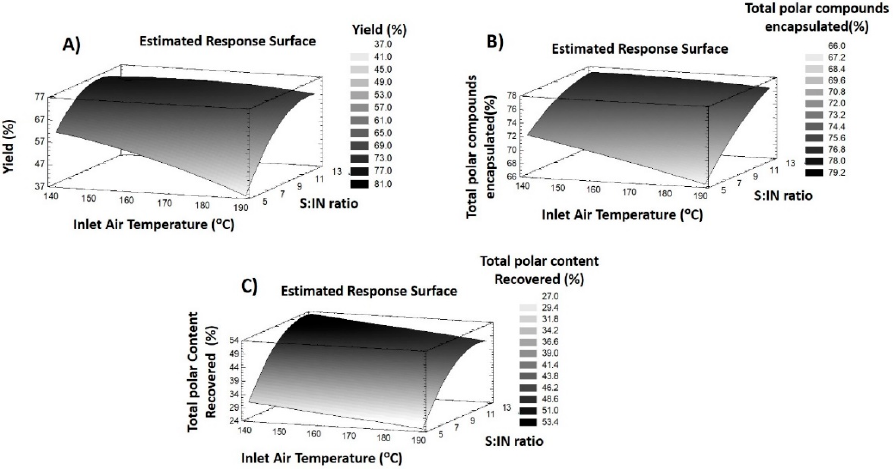
Figure 2. RSM plots of responses of inulin (IN) particles: (A ) Yield, ( B ) Total polar encapsulation and ( C ) Total polar recovery. Sample:Inulin (S:IN)